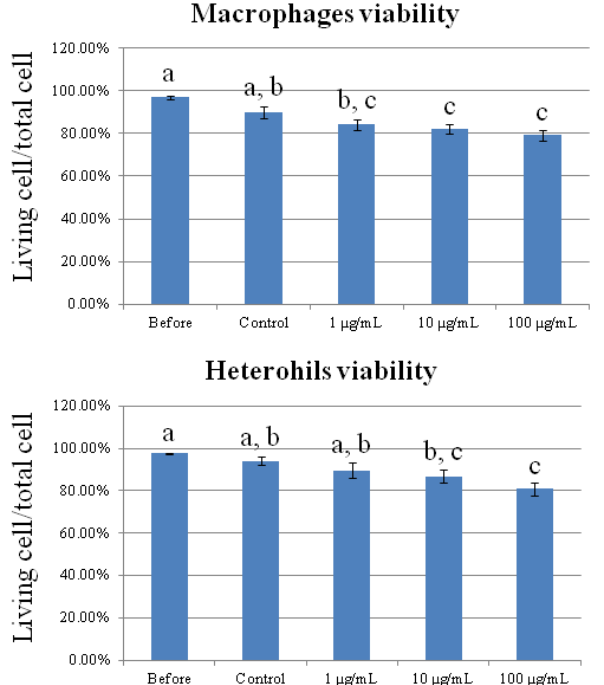
Figure 1. Viability of chicken macrophages and heterophils after 6 h of exposure to carbon nanotubes. Values are the mean ± SE of three batches. a–c The means with different superscripts differ significantly ( p <